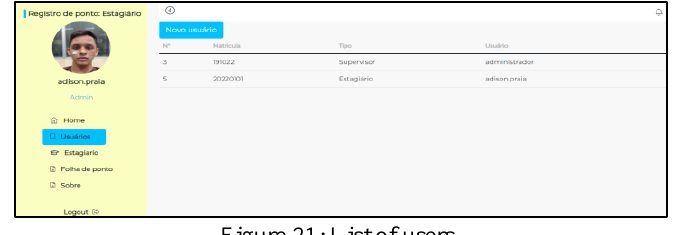
Figure 21: List of users.